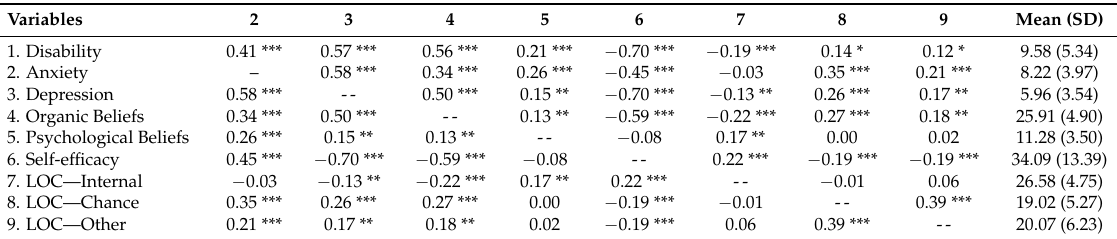
Table 1. Bivariate correlations and Means